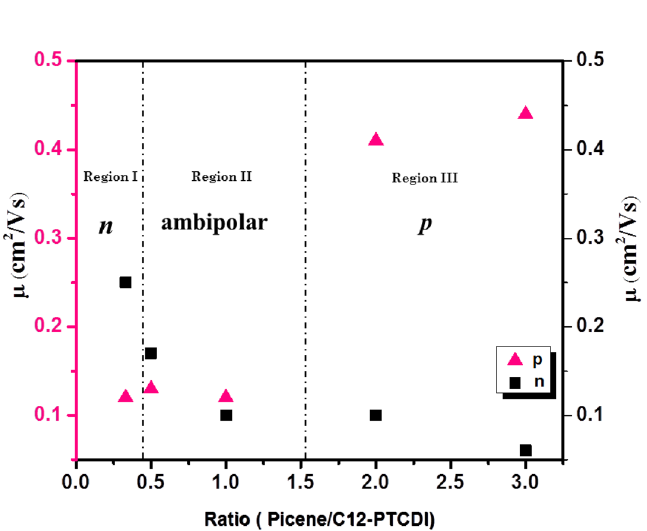
Figure 10. Varying mobilities plotted against D to A ratio for BHJ ambipolar OFET devices. Graphs were plotted using Origin software (https ://www.origi nlab.com/, version: 8.5) and Microsoft Office PowerPoint (https ://www.micro soft.com/en-in/micro soft-365/power point